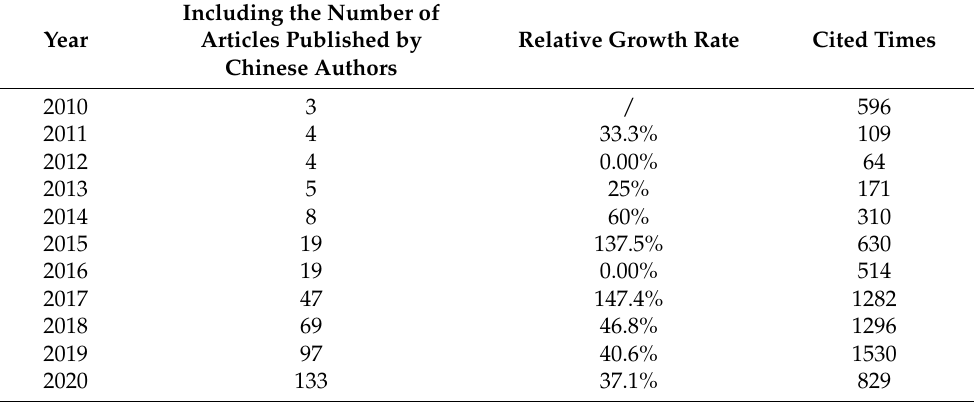
Table 2. Analysis, including the number of articles published by Chinese authors from 2010 to